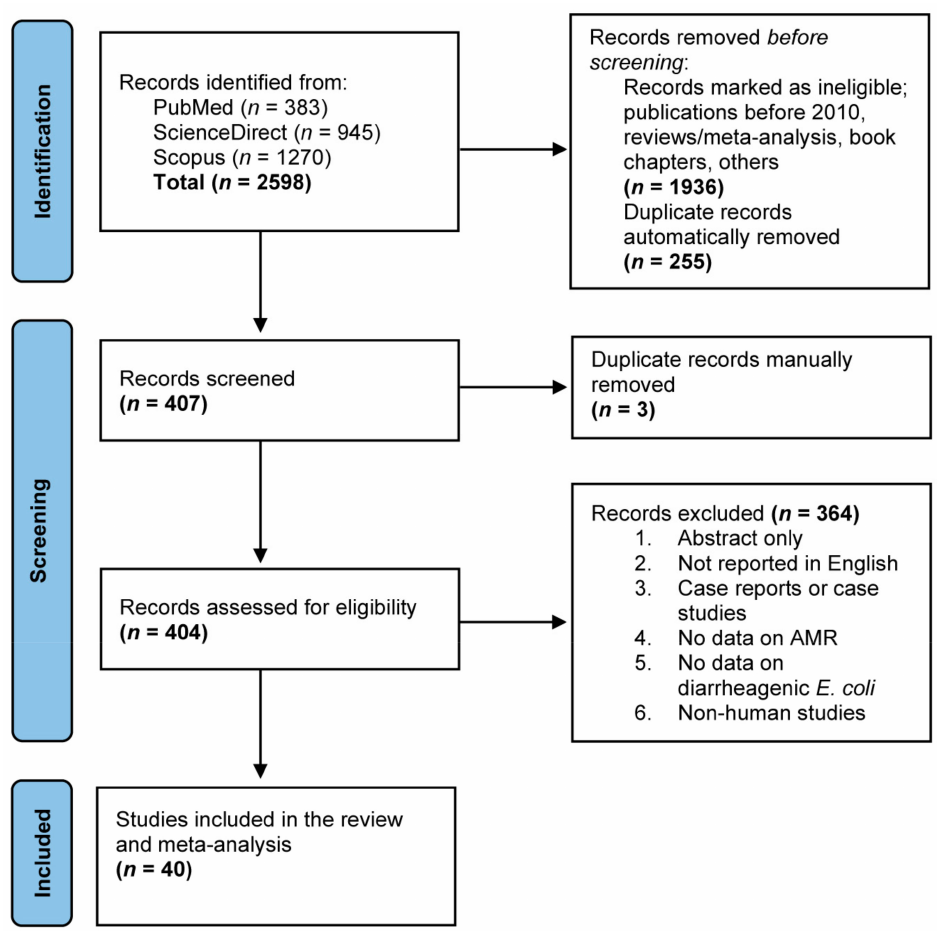
Figure 1. A PRISMA flow diagram of the study selection process. Three different electronic databases were utilized to search for eligible studies reporting antimicrobial-resistant diarrheagenic Escherichia coli (DEC) using defined search strategies. Records were combined and duplicates were removed using EndNote 20 software, followed by screening against predefined eligibility criteria before inclusion in the